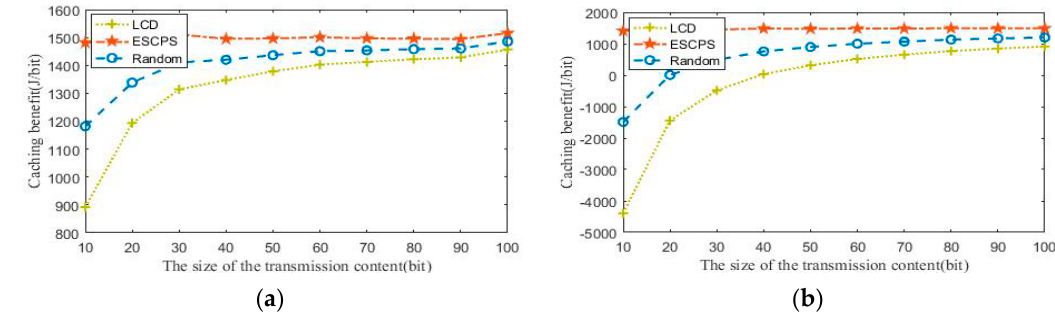
Figure 7. ( a ) The effect of distribution content size on content the efficiency of caching ( Pc = 0.1); ( b ) the effect of size on the efficiency of caching ( Pc = 1).